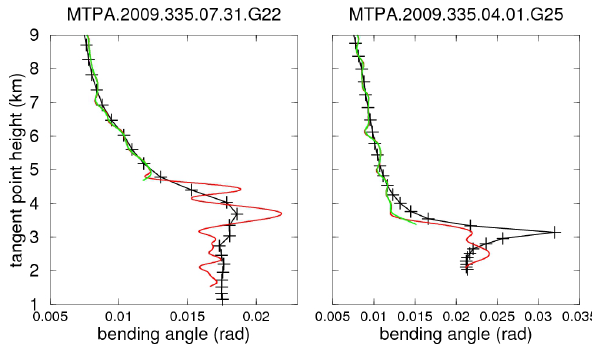
Fig. 24. Two examples of Metop/GRAS bending angles re- trieved by different processing modes: mode 1 – down to first gap (green); mode 2 – including small gaps (red). Black line shows ECMWF bending angles for comparison.